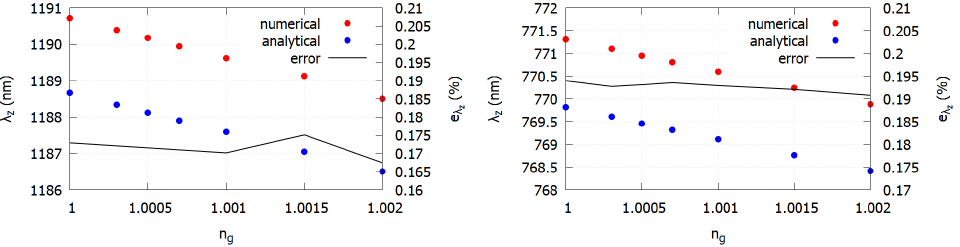
Figure 10. Zero GVD wavelength λ z versus the filling material refractive index n g of fiber F#2 in the second ( left ) and third ( right ) transmission bands, obtained from numerical (red dots) and analytical (blue dots) results. The relative error is shown in